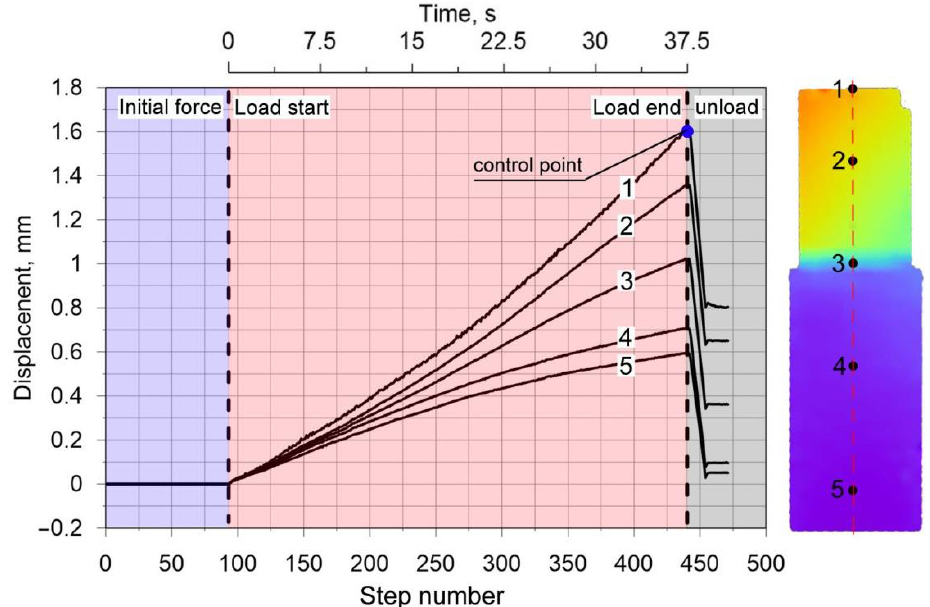
Figure 7. U z displacement diagram for five selected measuring points.